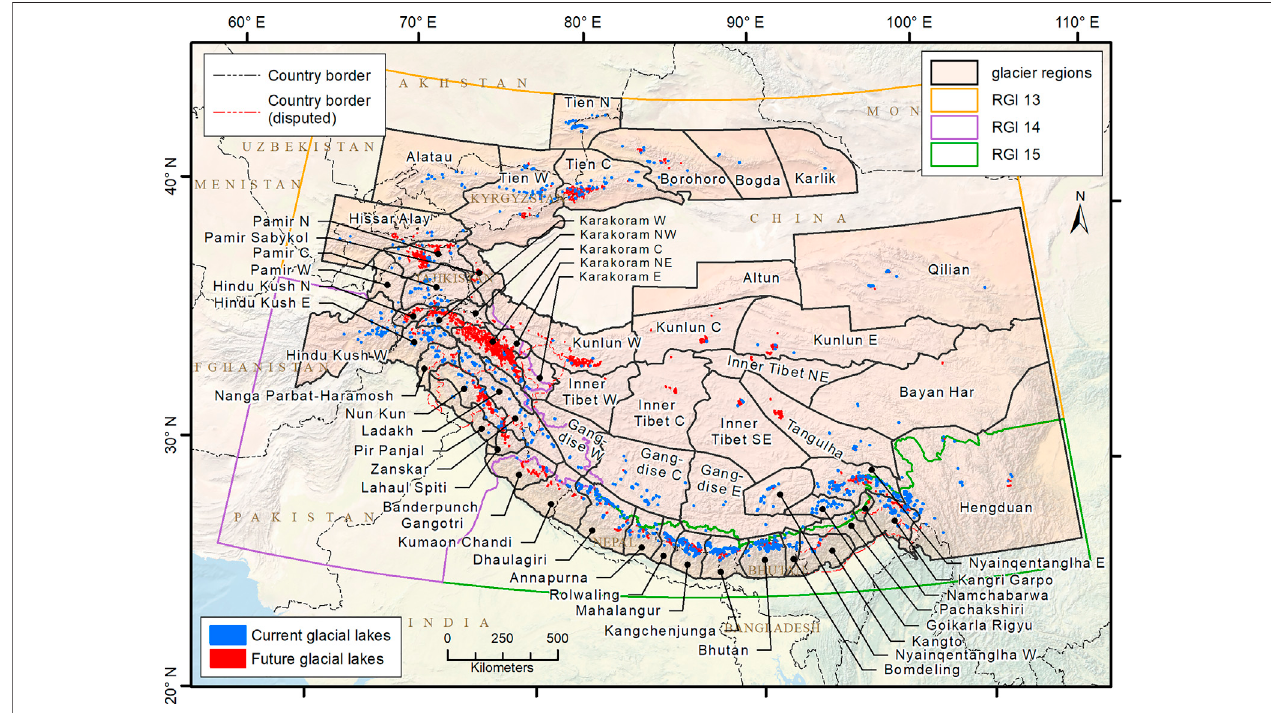
FIGURE 1 | Overview of the study area with current glacial lakes ( > 0.05 km 2 , blue areas) by Shugar et al. (2020) and future glacial lakes ( > 0.1 km 2 , red areas) by Furian et al. (2021). Glacier regions (in orange) are taken from Loibl (2020) and international (disputed) borders are part of the World Bank Of fi cial Boundaries dataset (World Bank, 2020). For better visibility, glacial lakes are not depicted to